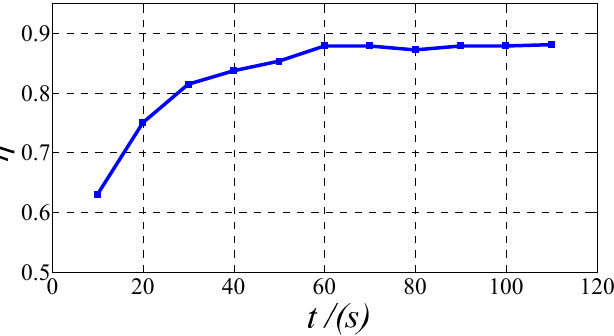
Figure 19. Experimental results of the overall system efficiency.